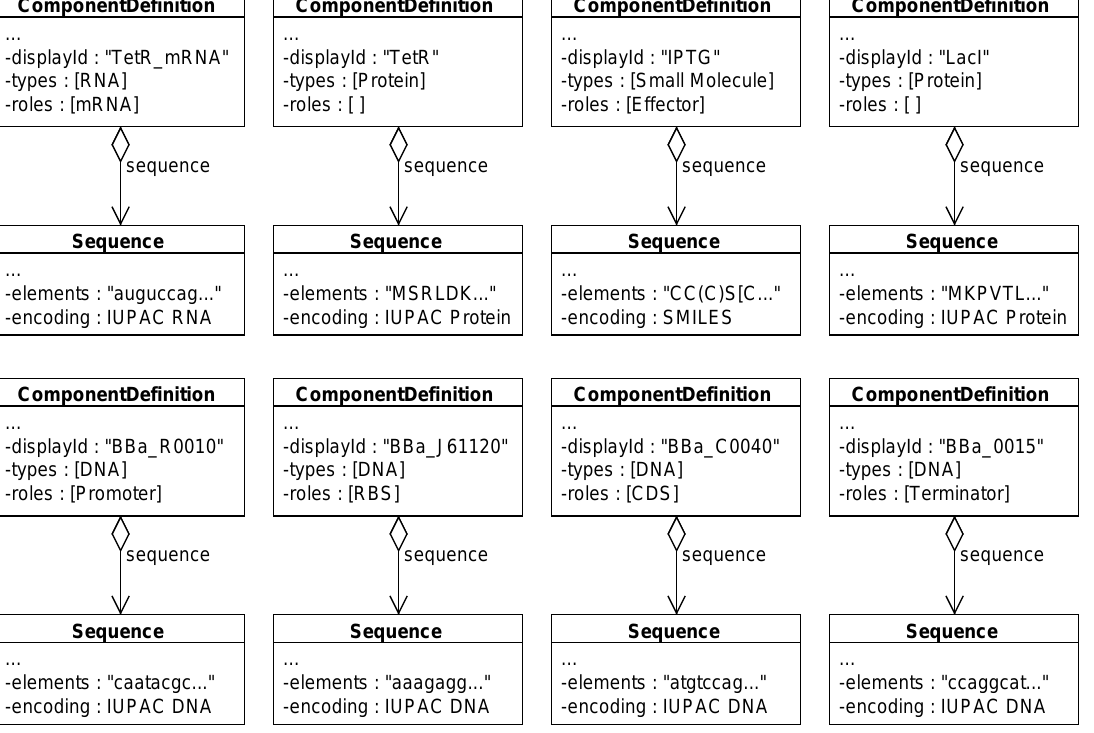
Figure 29: ComponentDefinition objects for the LacI inverter. These include ComponentDefinition objects based on DNA parts from the iGEM Parts Registry and ComponentDefinition objects that represent TetR mRNA, TetR, LacI, and IPTG. Each ComponentDefinition is associated with a Sequence that has an IUPAC DNA/RNA or IUPAC protein encoding , except the ComponentDefinition of IPTG, which is associated with a Sequence that has a SMILES encoding